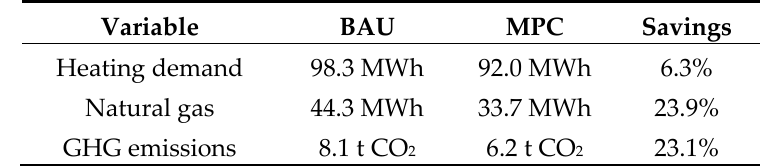
Figure 5. Daily average natural gas power demand: early results of the MPC implementation (winter 2019). Table 2. Savings obtained from MPC implementation vs BAU operation (early results, winter